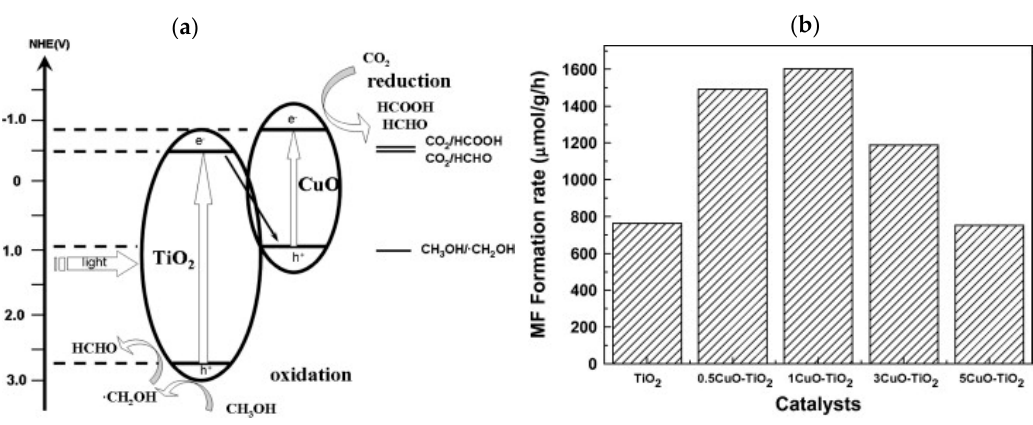
Figure 13. Photocatalytic conversion of CO 2 to methyl formate (MF) over CuO–TiO 2 . ( a ) Band positions of CuO and TiO 2 . ( b ) Formation rate of MF for the different catalysts. Reproduced from work in [38]. Copyright 2010 Elsevier Inc.